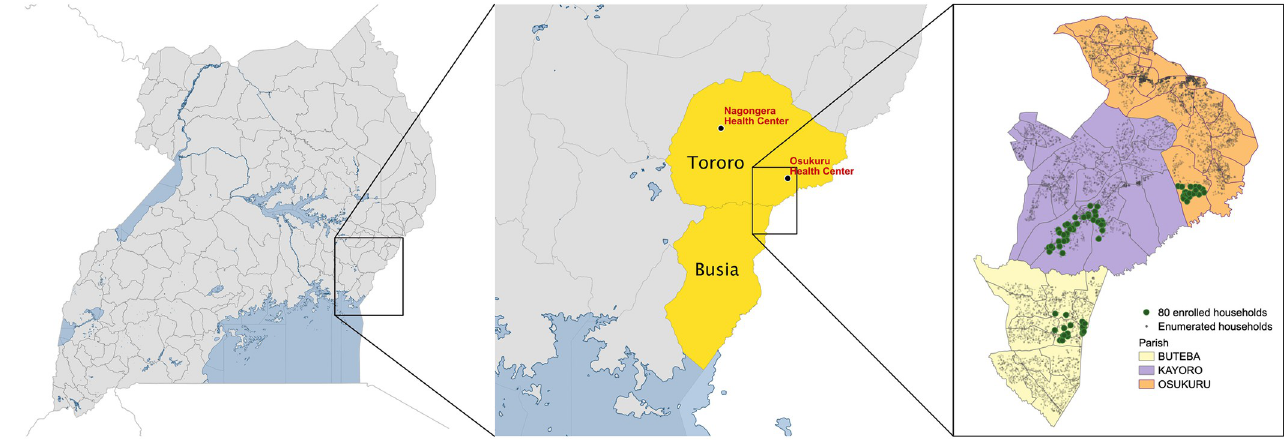
Fig 1. Map of Uganda with an extract showing study